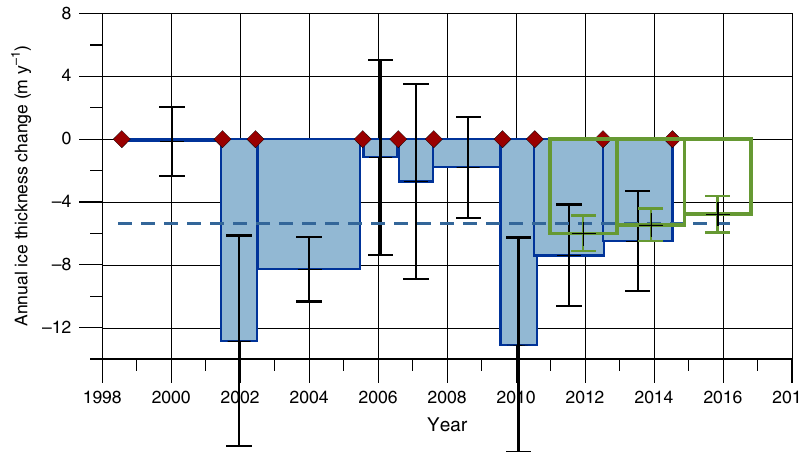
Fig. 5 Thickness changes of 79 North Glacier based on the migration of Midgardsormen. Temporal evolution of annual mean thickness changes as inferred from the displacement of Midgardsormen between 1998 and 2015. Red dots: date of grounding line detection, blue dashed line: mean annual thickness change between 1998 and 2016. The green boxes represent ice thickness changes from TanDEM-X surface elevation differences derived for recent periods over a larger part of the fl oating ice shelf. The vertical lines represent the error of the